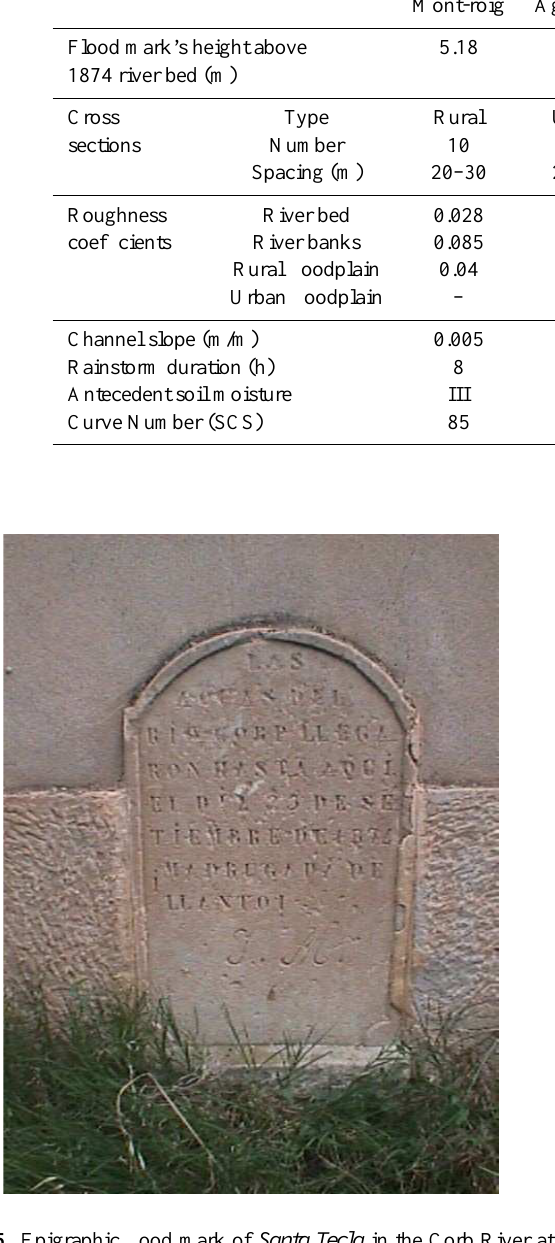
Fig. 5. Epigraphic flood mark of Santa Tecla in the Corb River at the base of a wall of Hostal del Teuler at